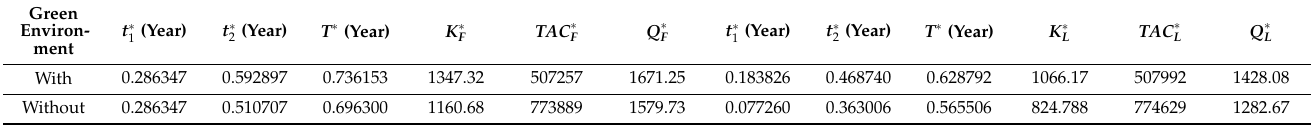
Table 3. Comparison of optimal solution of FIFO and LIFO policies with or without green technology.